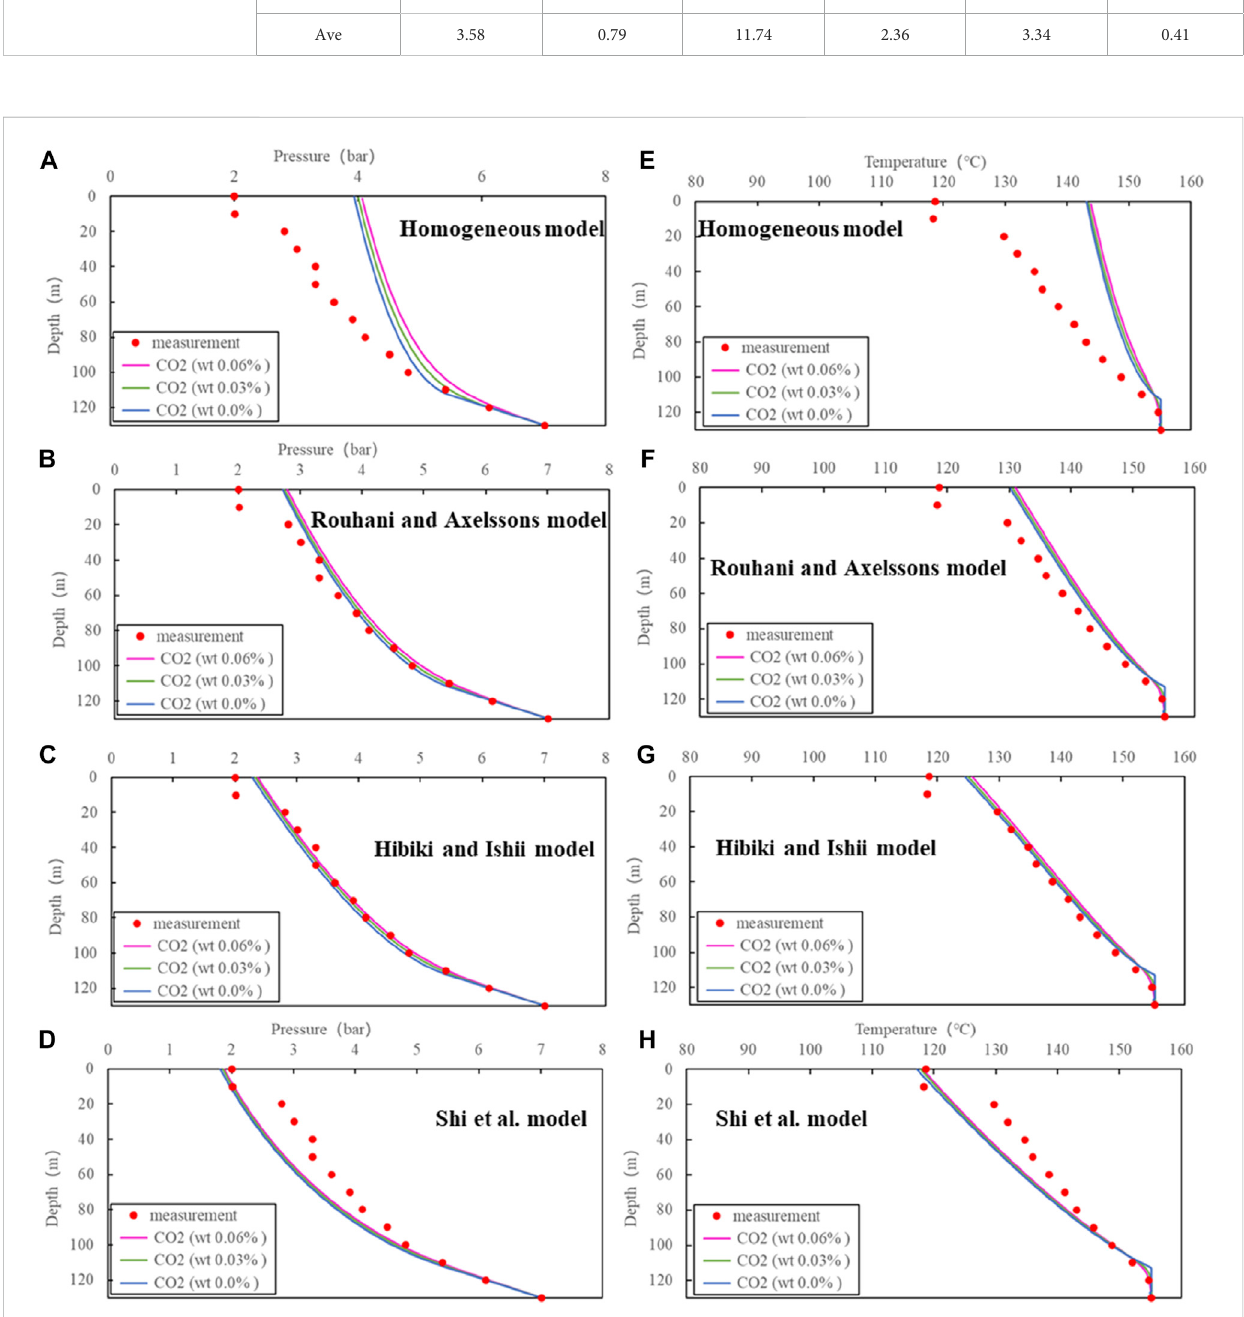
FIGURE 8 Comparison of simulations with different models and measurements for ZK303: (A) , (B) , (C) and (D) for pressure, (E) , (F) , (G) and (H) for temperature.